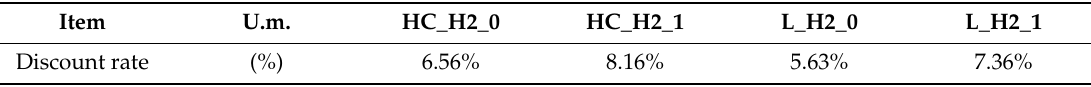
Table 7. Discount rates assumed in the calculation for analyzed gasification technologies.